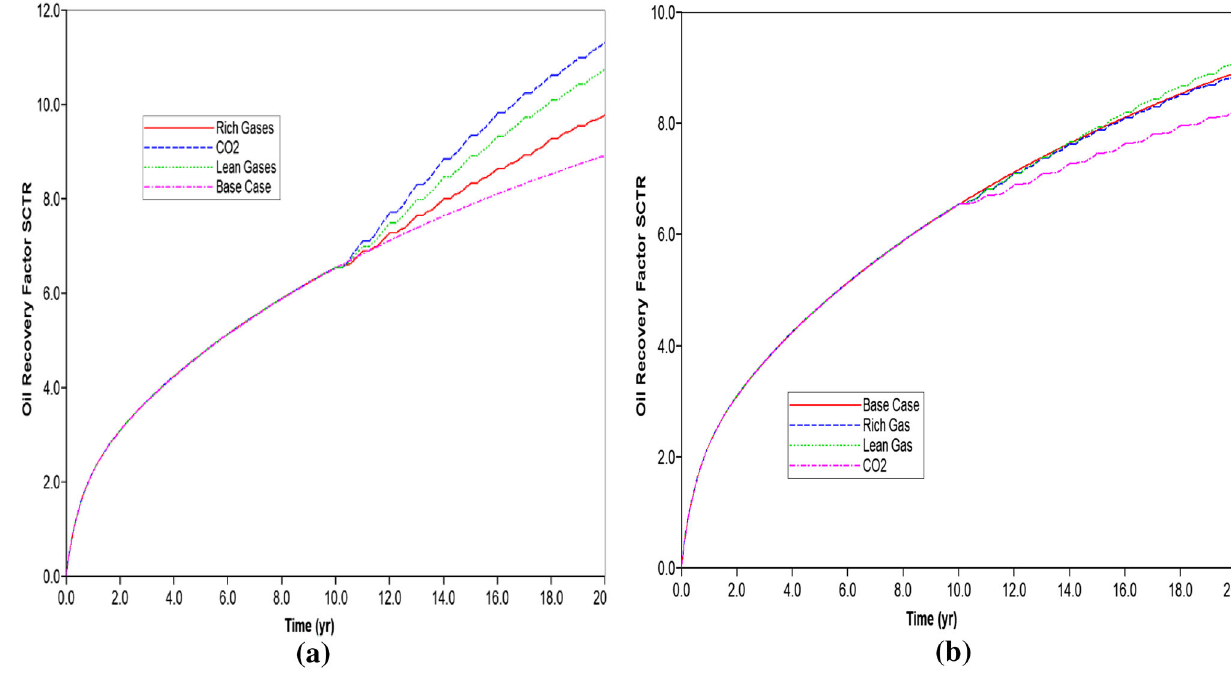
Fig. 17 Miscible gases performance in Bakken model for the 3rd scenario. a Case 3, b Case 4